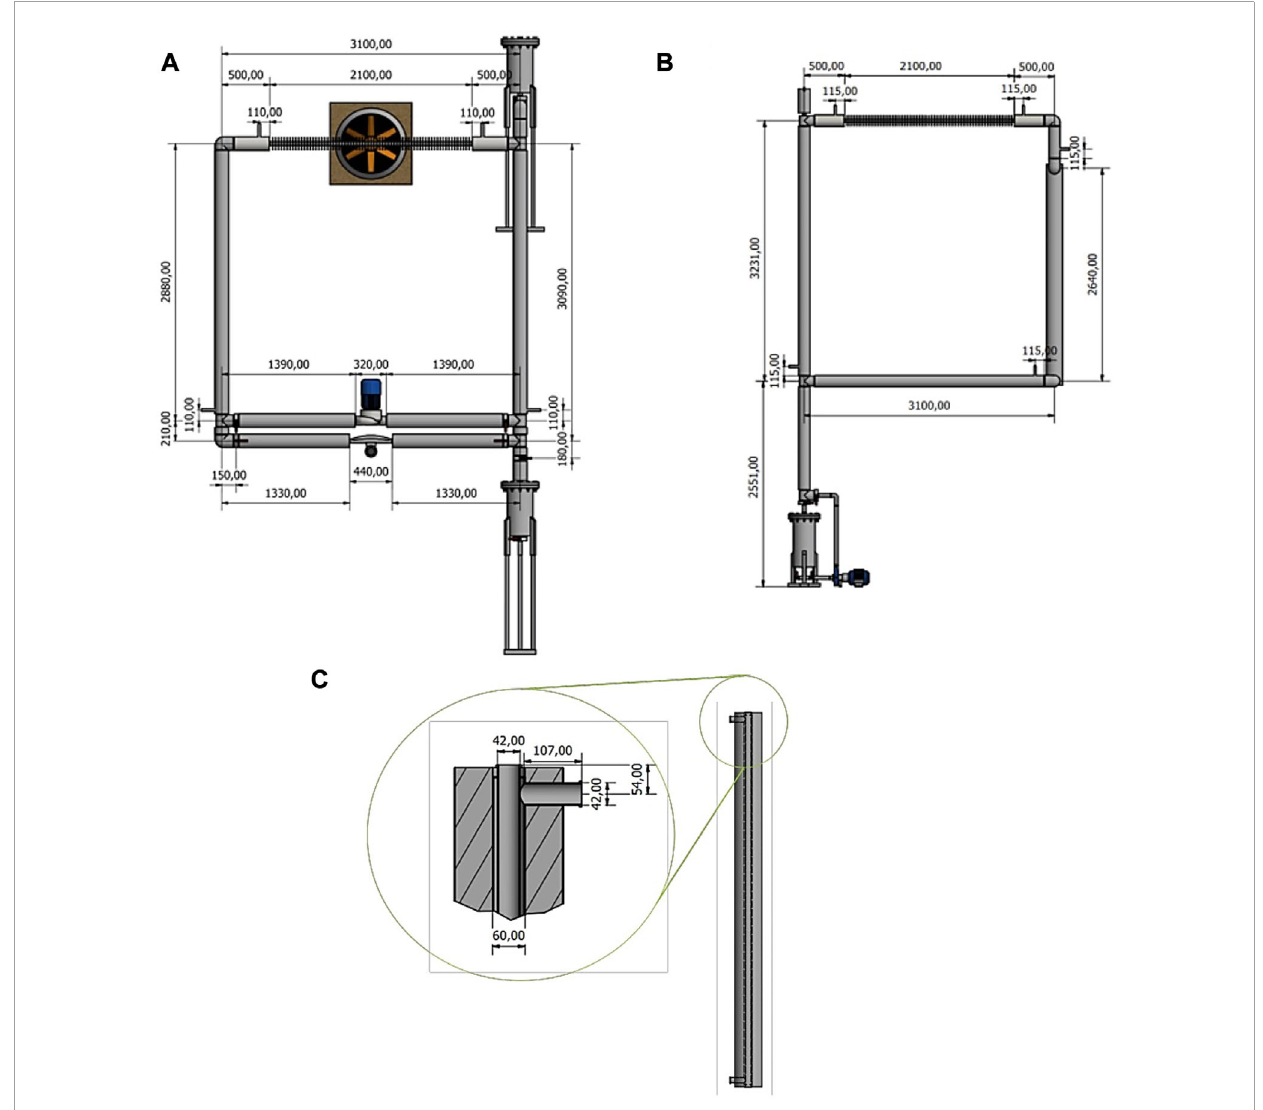
FIGURE 2 (A) DYNASTY geometrical view, (B) eDYNASTY geometrical view, and (C) DYNASTY–eDYNASTY heat exchanger coupling.